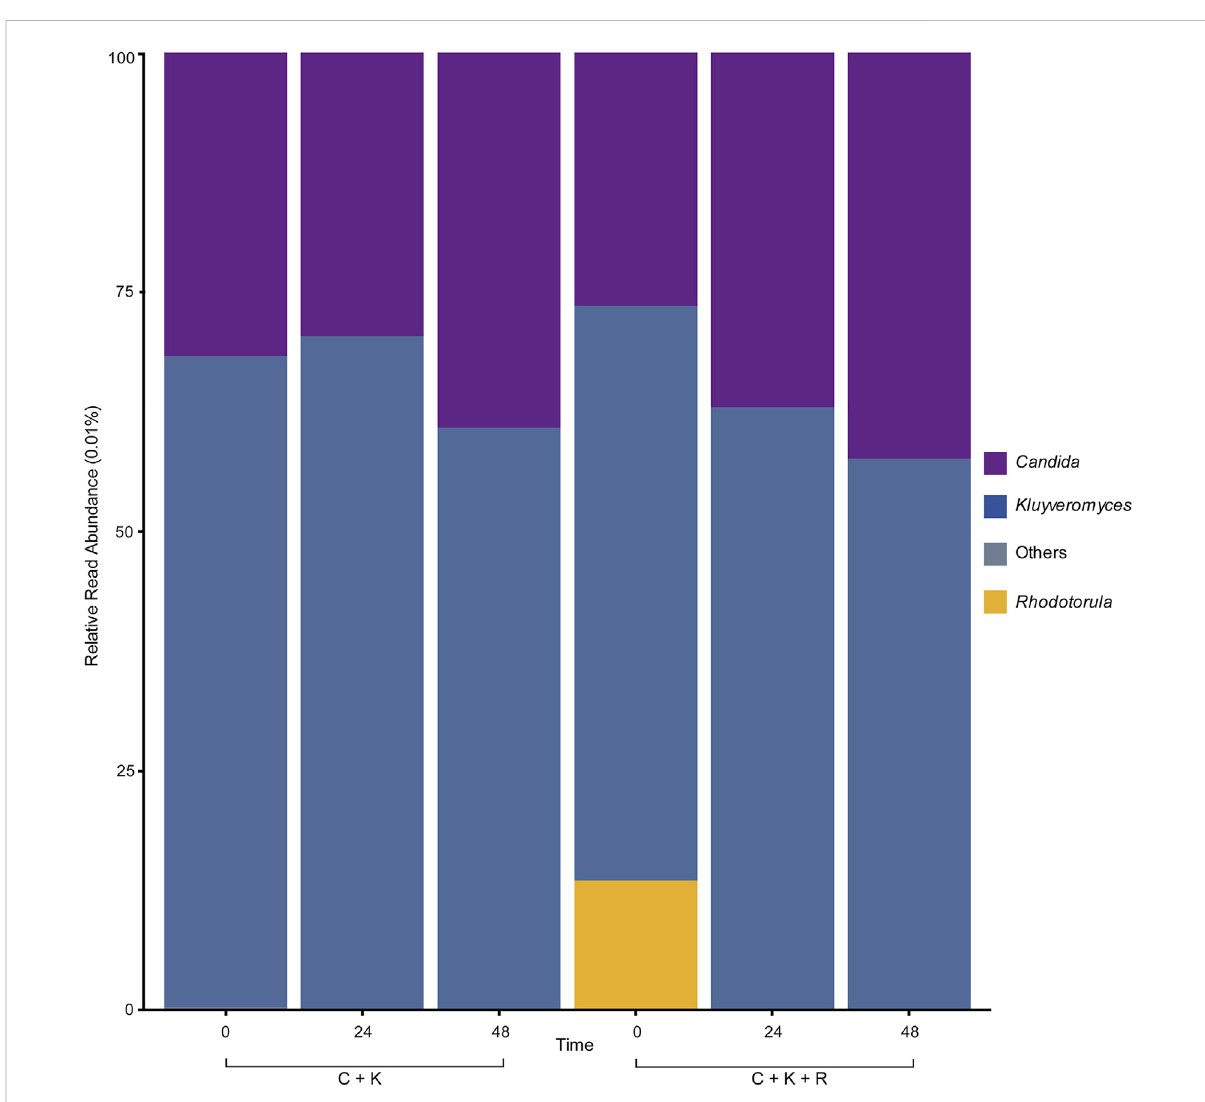
FIGURE 1 Genus-levelrelativereadabundancesofthemixedyeastculturesthroughouttheexperiment. ‘ Others ’ referstoyeastgenerawitharelativeread abundance of <